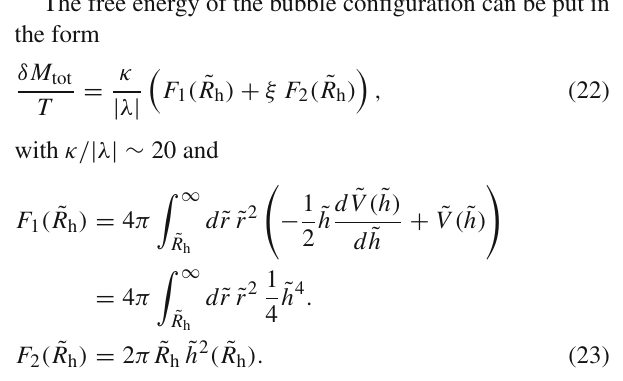
apparent that the characteristic scale of the Higgs configura- tion is comparable to the horizon radius for